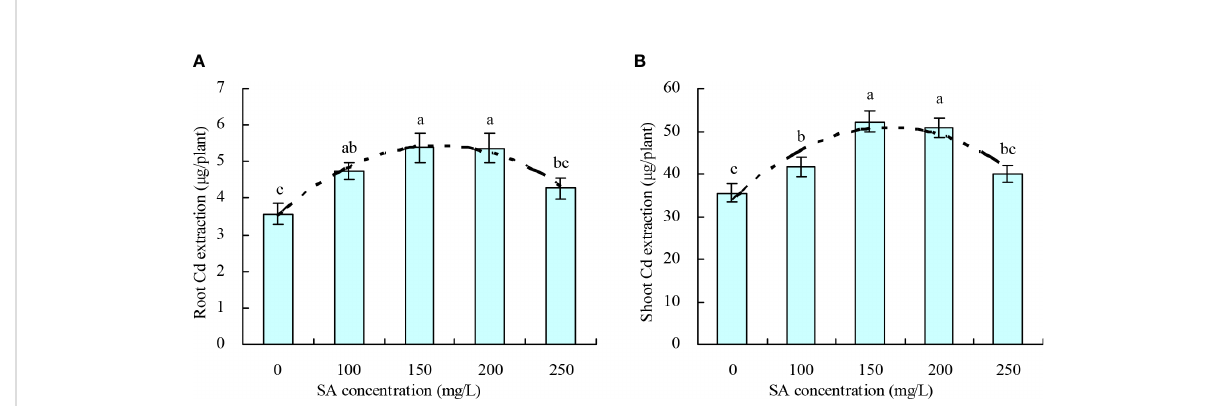
FIGURE 3 Cd extraction by Nasturtium of fi cinale . (A) Root Cd extraction; (B) shoot Cd extraction. Data shown are mean values ( ± SE) of three replicates. Different lowercase letters indicate signi fi cant differences among the treatments (Duncan ’ s Multiple Range Test, P < 0.05). Root Cd extraction, Cd content in roots × root biomass; shoot Cd extraction, Cd content in shoots × shoot